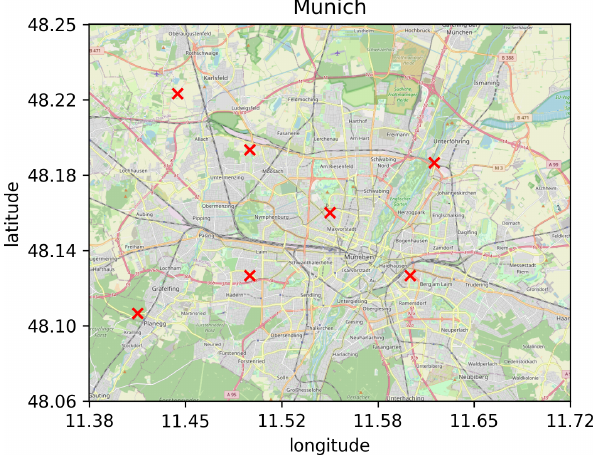
Figure 3. Map of exemplary measurement locations for Munich using seven measurement stations, which represents a ratio m of approximately 75% (background: OpenStreetMap contributors,